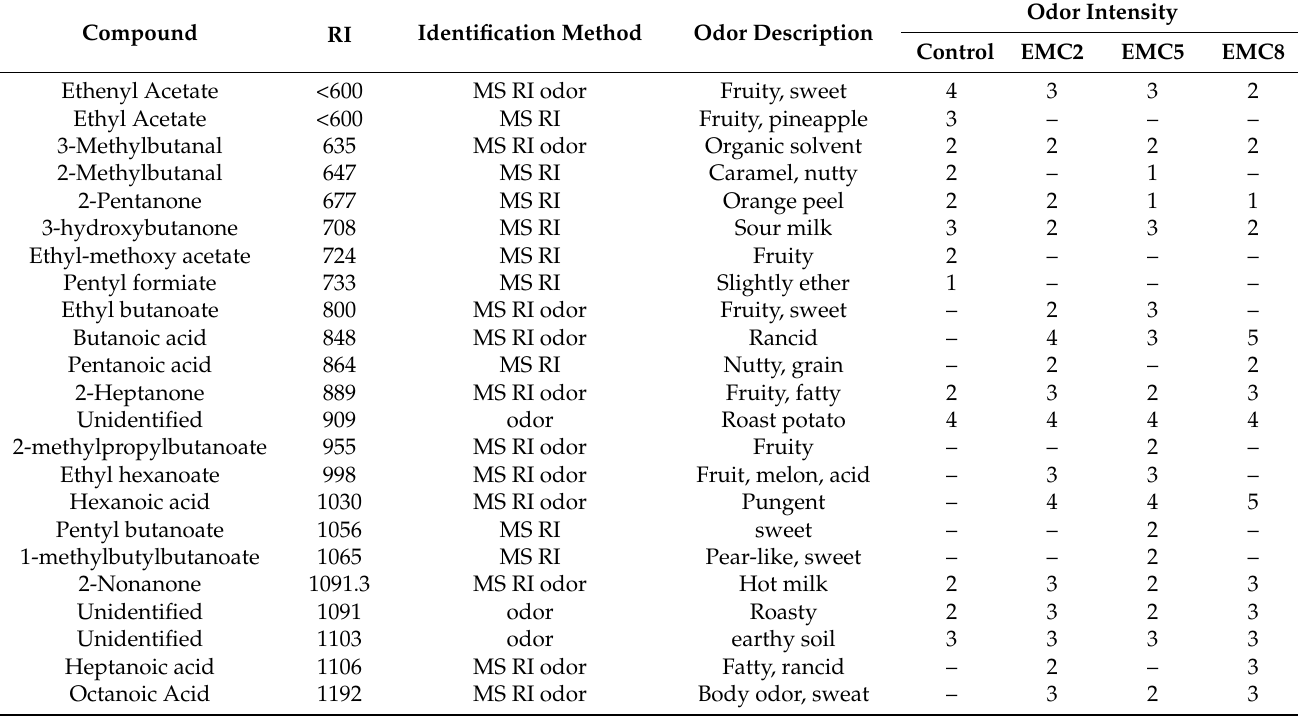
Table 5. Relative intensities of odor-active compounds in the headspace of the control group and EMCs made by the three lipases for 16